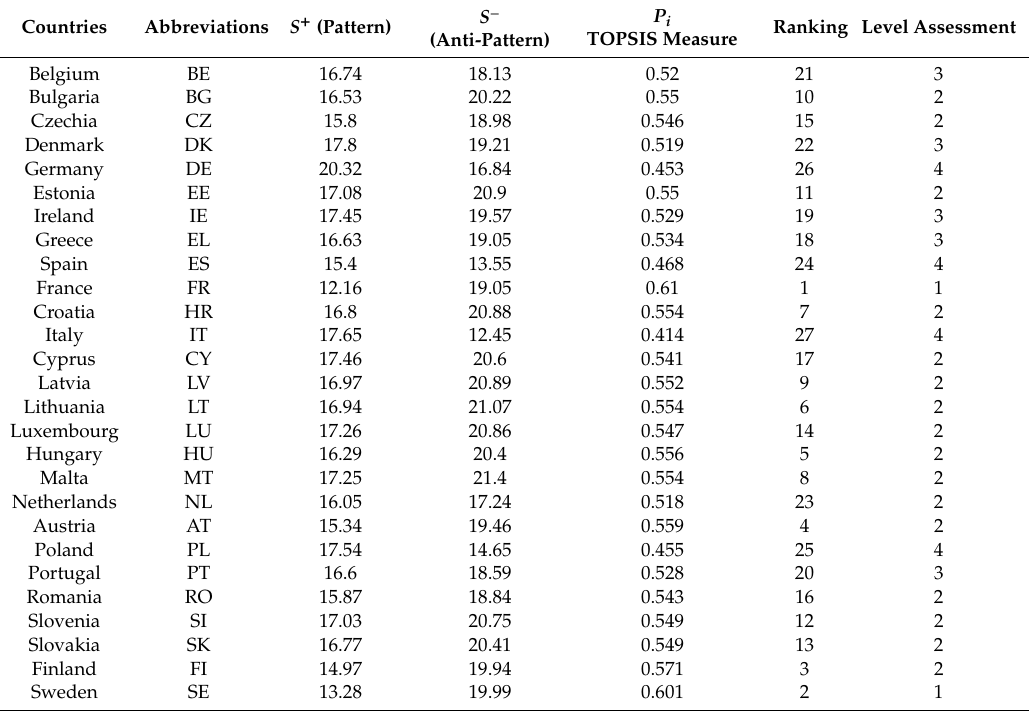
Figure 5. Ranking and level assessment of the EU-27 countries in terms of sustainable energy development (( a ) ranking, ( b ) level assessment). Table 3. Distance of the EU-27 countries from the ideal and non-ideal solutions together with the TOPSIS measure of sustainable energy development.